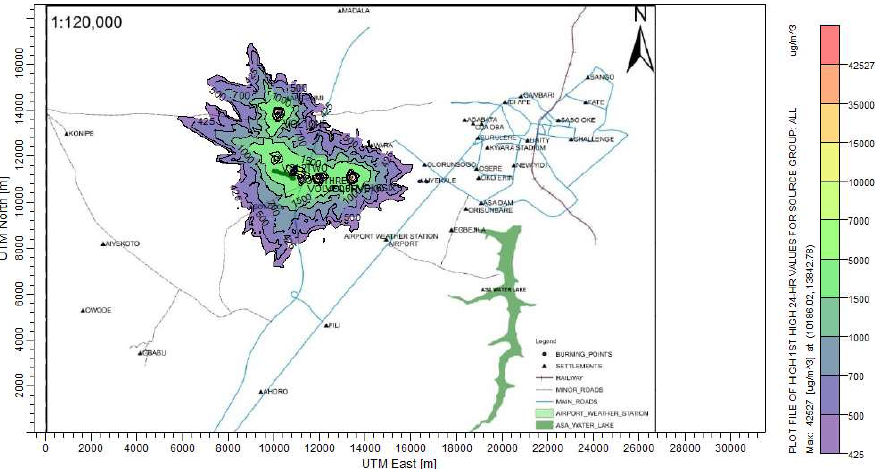
Figure 8. Isopleth of 24-h ground level NO x from Sokoto-Aiyekale dump site.